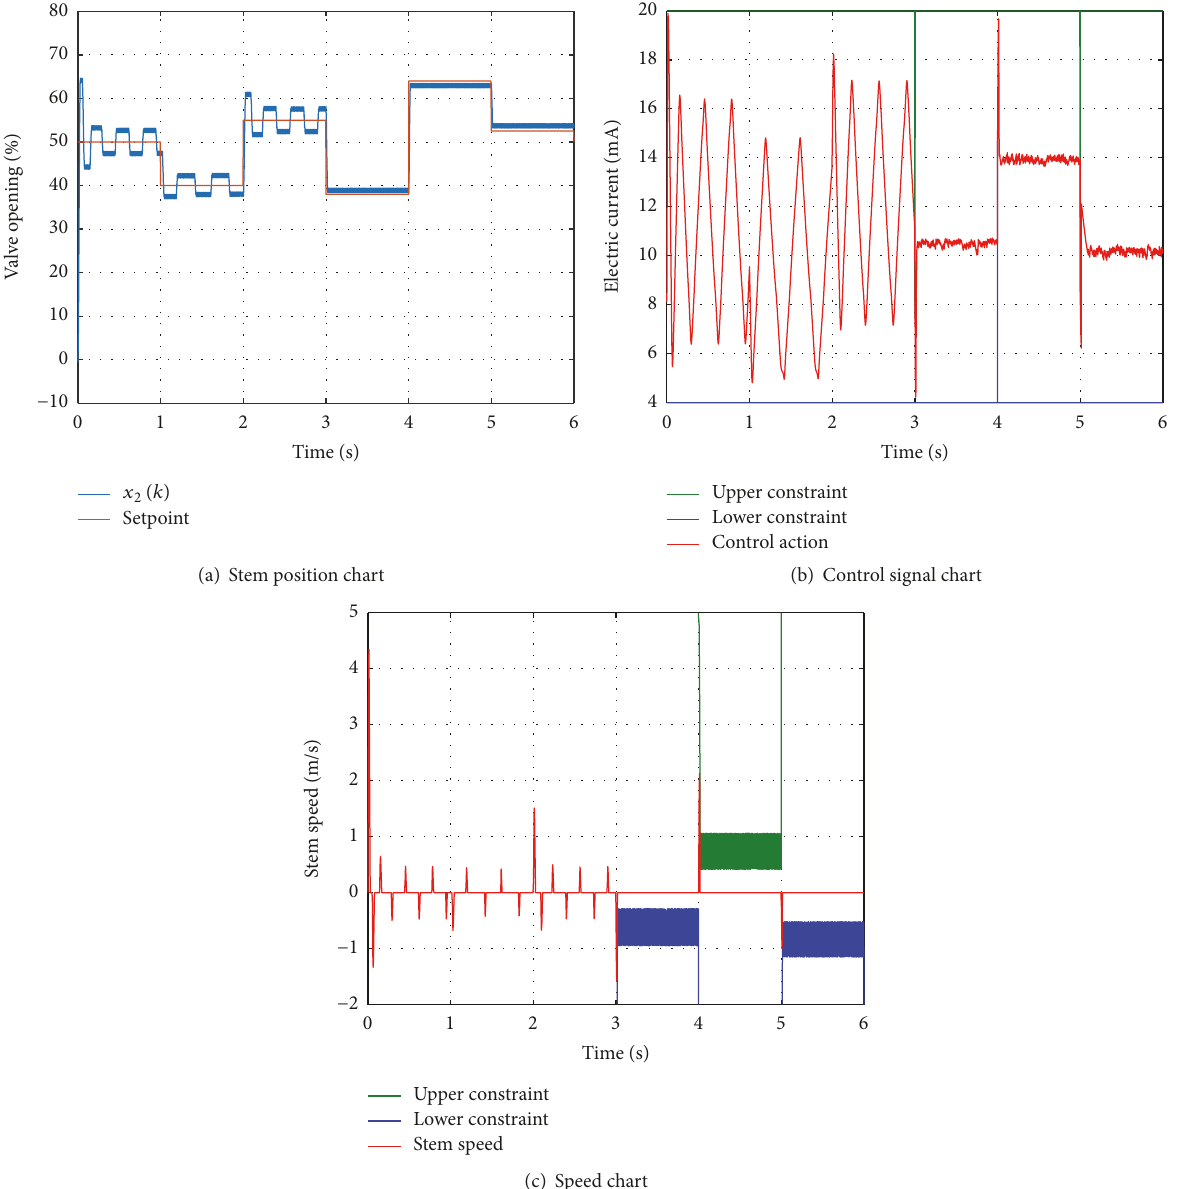
Figure 7: Simulation